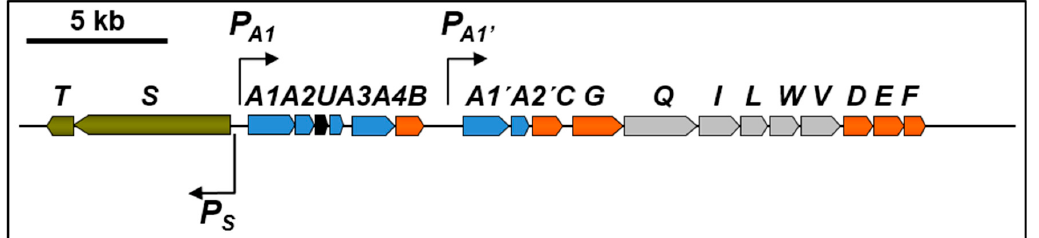
Figure 2. Organization of the chromosomal thn genes in TFB. The arrows show the directions of gene transcription. Bent arrows represent the identified promoters.